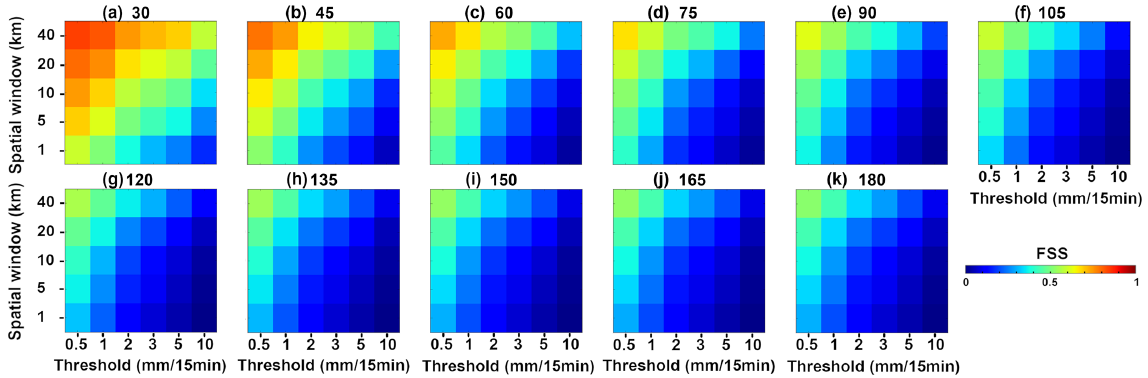
Figure 7. The 10-events mean FSS obtained with PIAF for the different precipitation thresholds (0.5, 1, 2, 3, 5 and 10mm/15min) and window sizes (1, 5, 10, 20 and 40km) at each forecast lead time from (a) 30min to (k)